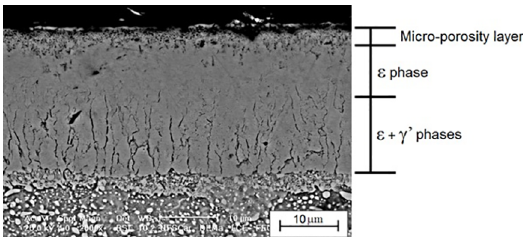
Figure 5. SEM micrograph of the surface modified layer for a nitrocarburized sample, showing the micro-porosity layer on top and the presence of ɛ and γ' phases.